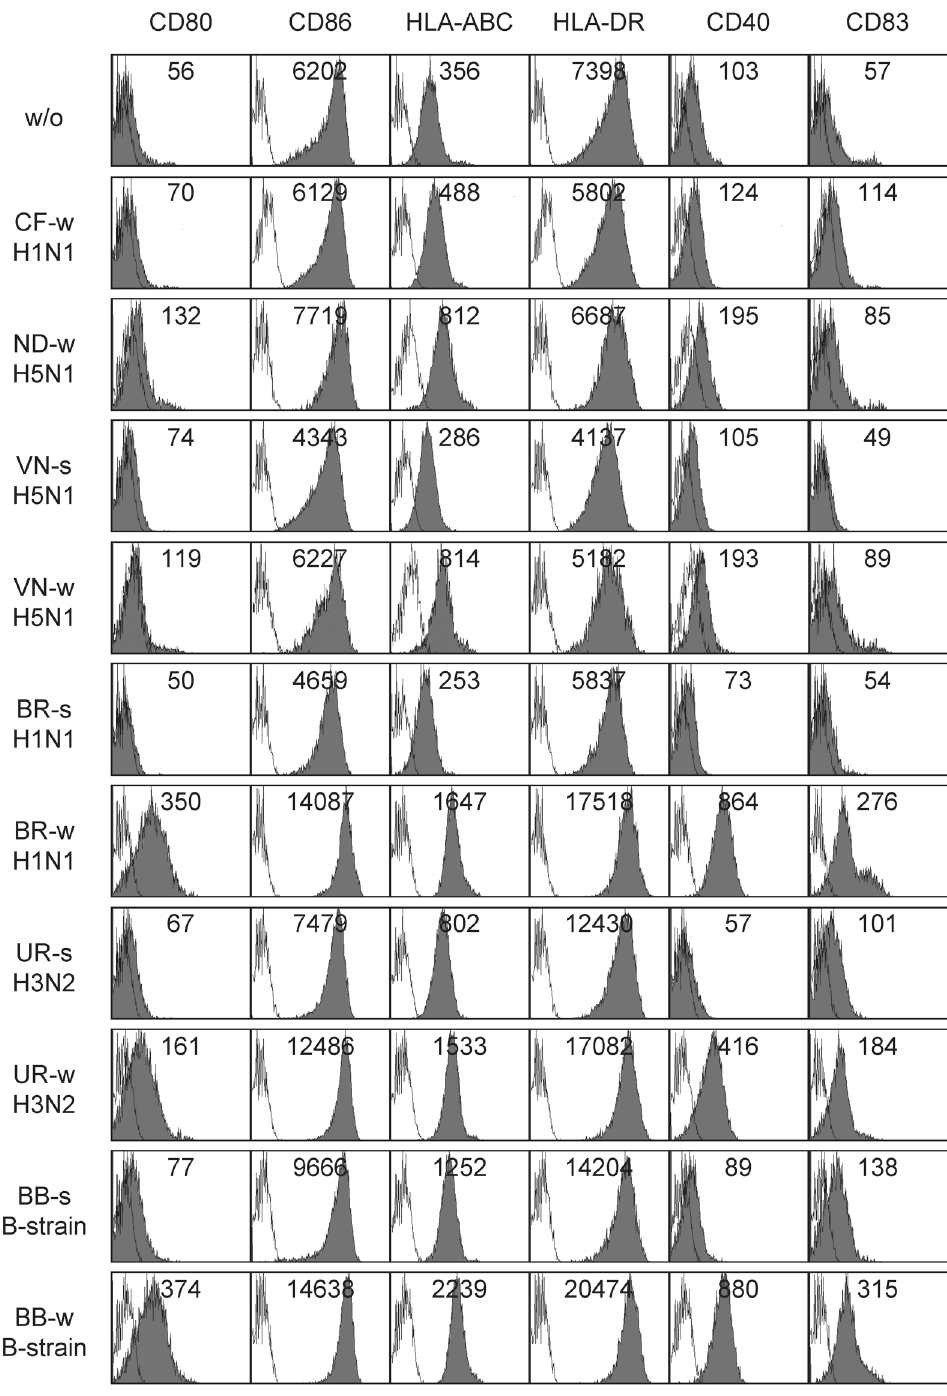
Figure 1. Vaccine-induced DC maturation in healthy donor HD15. Immature DC of donor HD15 were incubated for 48 h with different pandemic (-like) and seasonal influenza virus vaccines at 10 m g/mL (referring to HA content) and were subsequently analyzed by flow cytometry for expression of maturation markers on viable 7AAD-negative cells (grey histograms). Split virus formulations were unavailable from pandemic (-like) strains A/H1N1-California and A/H5N1-Indonesia. Unfilled histograms represent IgG isotype control stainings. MFI values were added to each histogram. For abbreviations of virus strains see Table 1. s, split virus; w, whole virus; w/o, without. doi:10.1371/journal.pone.0103392.g001 representative donor, IFN- c secreting CD4 + and CD8 + T cells virus vaccine reactive CD4 + precursors were highest for seasonal were observed upon stimulation with every influenza whole virus strains A/H3N2-Uruguay and B/Brisbane, and were slightly vaccine preparation tested (Fig. 3A). Data summarized from the lower for seasonal strain A/H1N1-Brisbane and all pandemic (- entire study cohort demonstrated that the frequencies of whole like) strains (Fig. 3B). Median numbers (and ranges) per 10 5 CD4 +